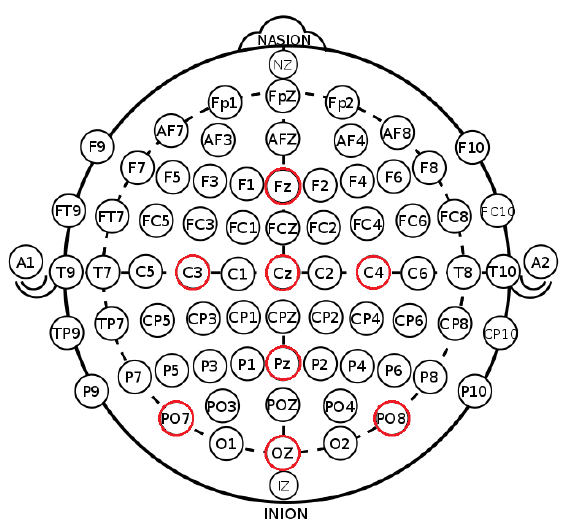
Figure 2. Location of the used EEG electrodes (marked in red): Fz, C3, Cz, C4, Pz, PO7, Oz, and PO8, according to the international 10–20